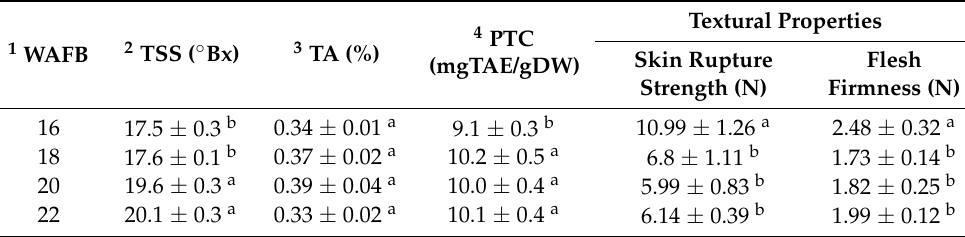
Figure 1. Changes in total soluble solids (TSS) content, titratable acidity (TA), and Brix/acid ratio of Shine Muscat grapes during ripening. Table 1. Changes in total soluble solids content, titratable acidity, polymeric tannin content, and textural properties of Shine Muscat grapes during ripening from 16 to 22 WAFB.